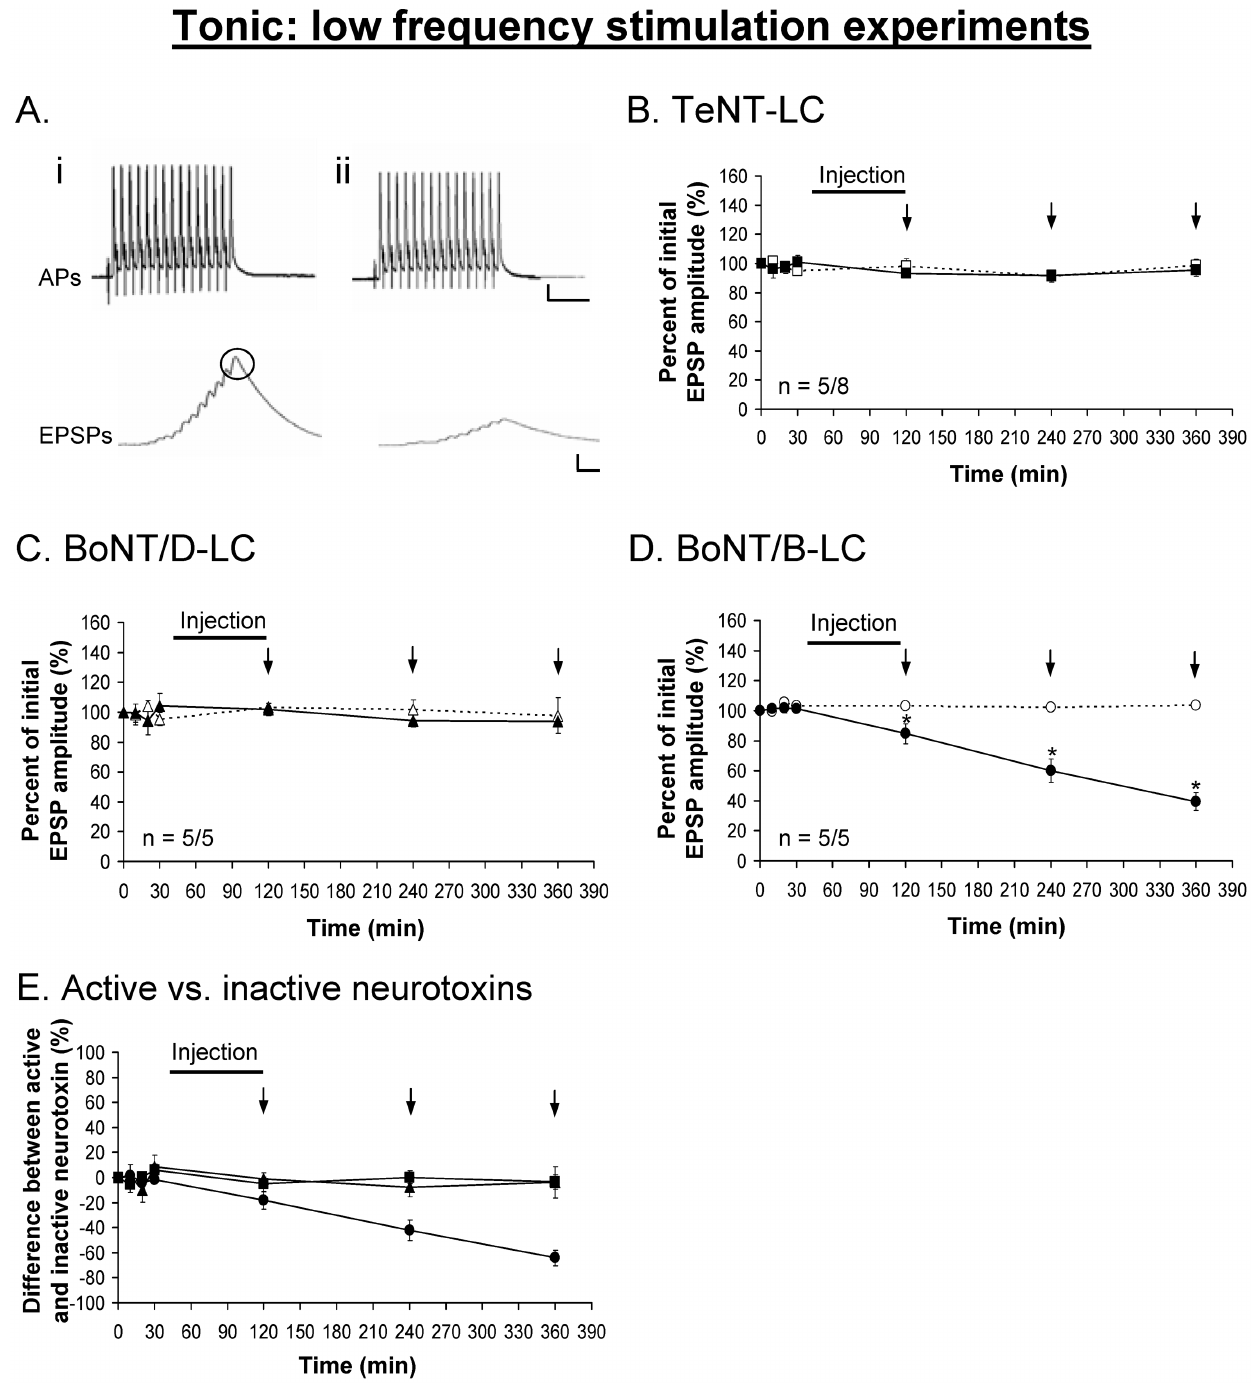
Figure 4. Tonic EPSPs are inhibited using BoNT/B-LC under low frequency stimulation. A , Example showing the tonic action potentials (APs, 200 Hz) remain unchanged before ( i ) and after ( ii ) the injection of each neurotoxin (BoNT/B-LC used as the example). TeNT-LC ( B ) and BoNT/D- LC ( C ) did not have an effect on the tonic evoked response. E , Percent difference between active and inactive neurotoxin, in which the inactive neurotoxin is the reference point at 0%. In B-E , a solid black line represents the time course of neurotoxin injection (90 min) and vertical arrows ( Q ) represent when EPSPs were recorded. Active neurotoxins: TeNT-LC ( & ), BoNT/D-LC ( m ) and BoNT/B-LC ( D-LC ( g ) and BoNT/B-LC ( # ). Error bars represent S.E.M. The measured tonic (last) EPSP is encircled in black ( Ai ). An asterisk (*) denotes a significant difference (p , 0.05) and ‘n’ represents the sample size (active/inactive neurotoxin). Scale bars: horizontal – 10 ms; vertical – 10 mV (APs), 5 mV (EPSPs).